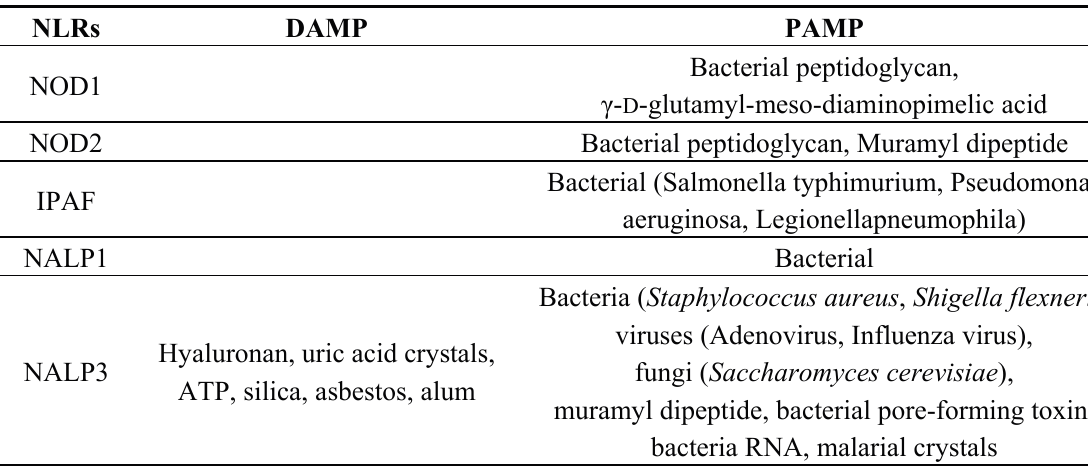
1. NLRs-recognized damage-associated molecular pattern DAMP and pathogen-associated molecular patternPAMP. NLRs DAMP PAMP Bacterial peptidoglycan, NOD1 γ - D -glutamyl-meso-diaminopimelic acid NOD2 Bacterial peptidoglycan, Muramyl dipeptide Bacterial (Salmonella typhimurium, Pseudomonas IPAF aeruginosa, Legionellapneumophila) NALP1 Bacterial Bacteria ( Staphylococcus aureus , Shigella flexneri ), viruses (Adenovirus, Influenza virus), Hyaluronan, uric acid crystals, fungi ( Saccharomyces cerevisiae ), NALP3 ATP, silica, asbestos, alum muramyl dipeptide, bacterial pore-forming toxin, bacteria RNA, malarial